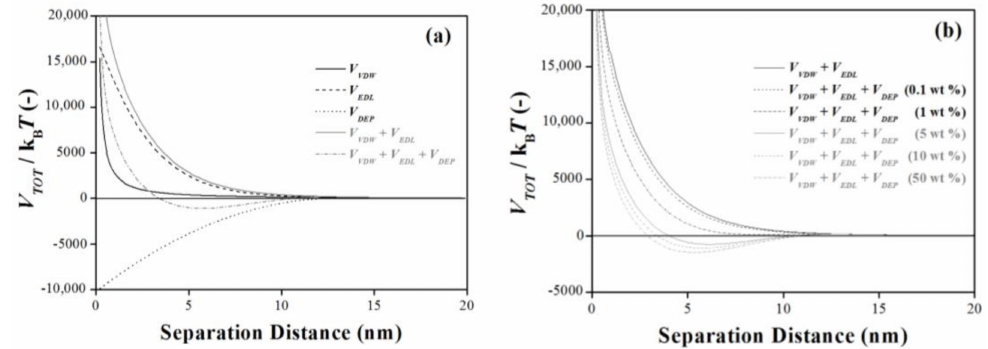
Figure 2. ( a ) The interaction energy profiles for the Derjaguin-Landau-Verwey-Overbeek (DLVO) with/without depletion attraction are represented as a function of separation distance h and ( b ) the energy profiles with varying concentrations of depletion reagent (0.1–50 wt %) are expressed as a function of the separation distance. The values of the silica-bubble-water Hamaker constant ( − 3.12 × 10 − 21 J), ionic strength (20 mM), silica surface potential ( − 0.02 V at pH 7), bubble surface potential ( − 0.025 V at pH 7), polymer radius of gyration (6.48 × 10 − 9 m) and polymer molecular weight (10 4 g/mol) are